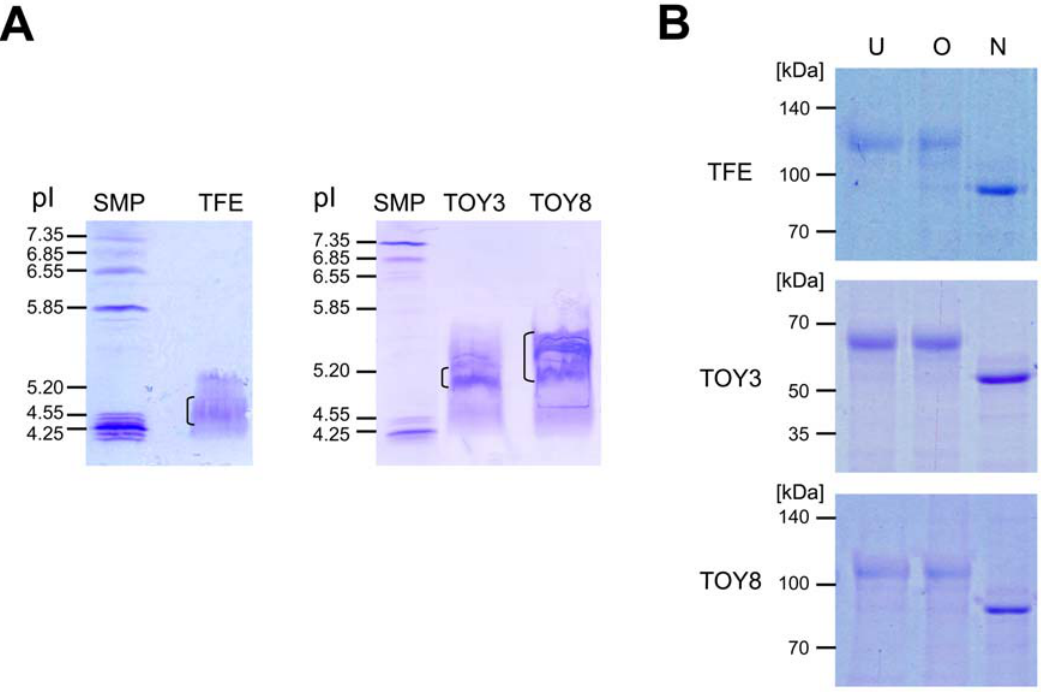
Figure 4. Isoelectric focusing and glycosylation analysis of TFE, TOY3, and TOY8. ( A ) 20 m g of the indicated protein was loaded on an IsoGel Agarose IEF Plate and run at 50 mA constant current for 3 hr. The gels were stained with Coomassie blue. Each bracket marks the pI range of the indicated protein. Reference pI values are indicated by the standard marker proteins (SMP). ( B ) 2 m g of the indicated protein was digested with O- glycosidase (O) and PNGase F (N) and was separated by SDS-PAGE and stained with Coomassie blue. Each undigested protein was used as control (U). Molecular masses (kDa) are indicated at left.